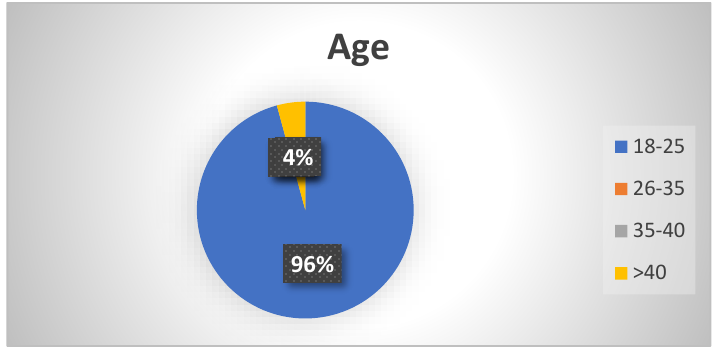
Figure 18. Age of the 71 university students.